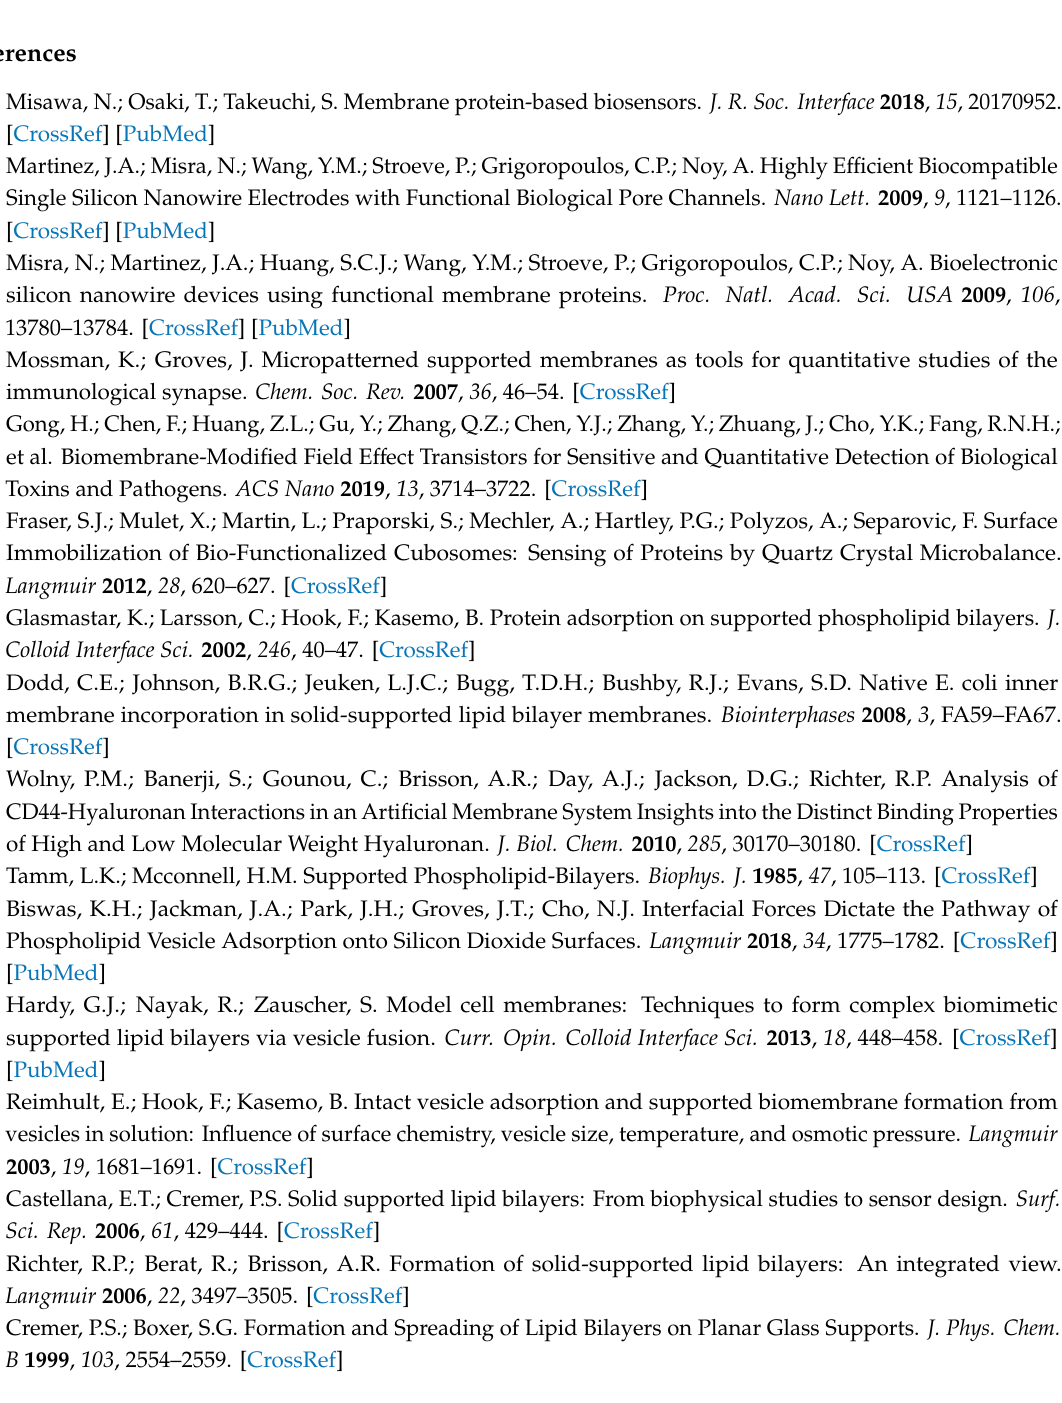
Figure 1 in the main manuscript plotted with error bars, which represent the standard error for a set of at least 3